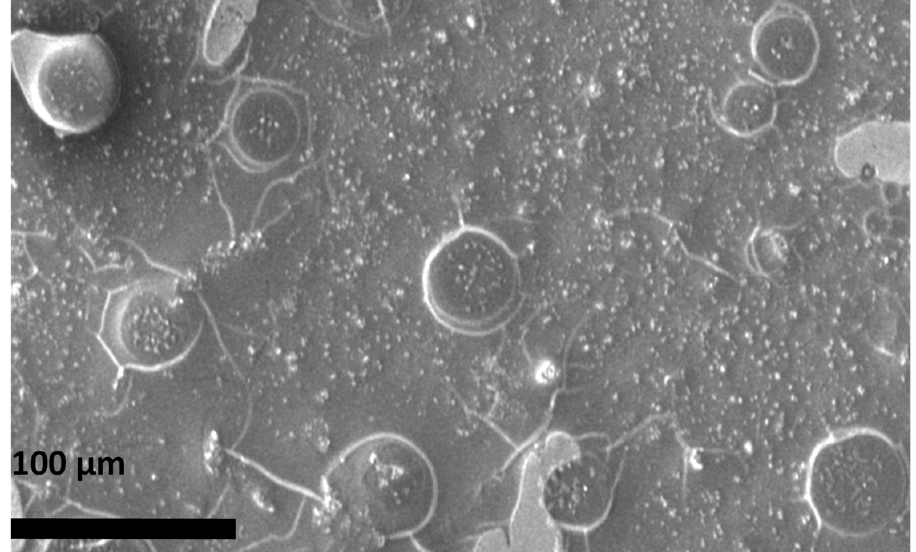
Figure 6. ESEM analysis of S.aureus treated with rGO@ZnO–Cu at 200× magnifications showing interaction with bacterial cells. Some cells have lysed due to deposition of rGO@ZnO–Cu on the surface.